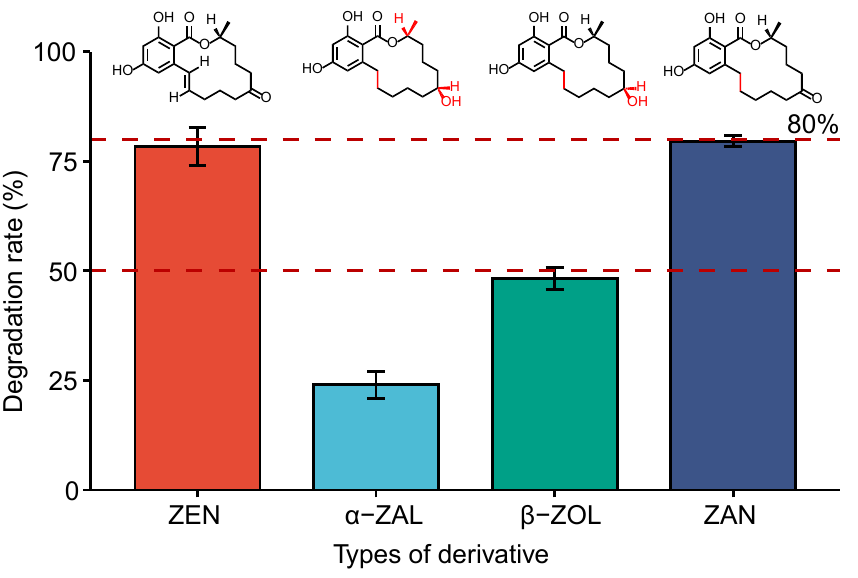
Figure 5. FSZ degradation of ZEN derivatives.